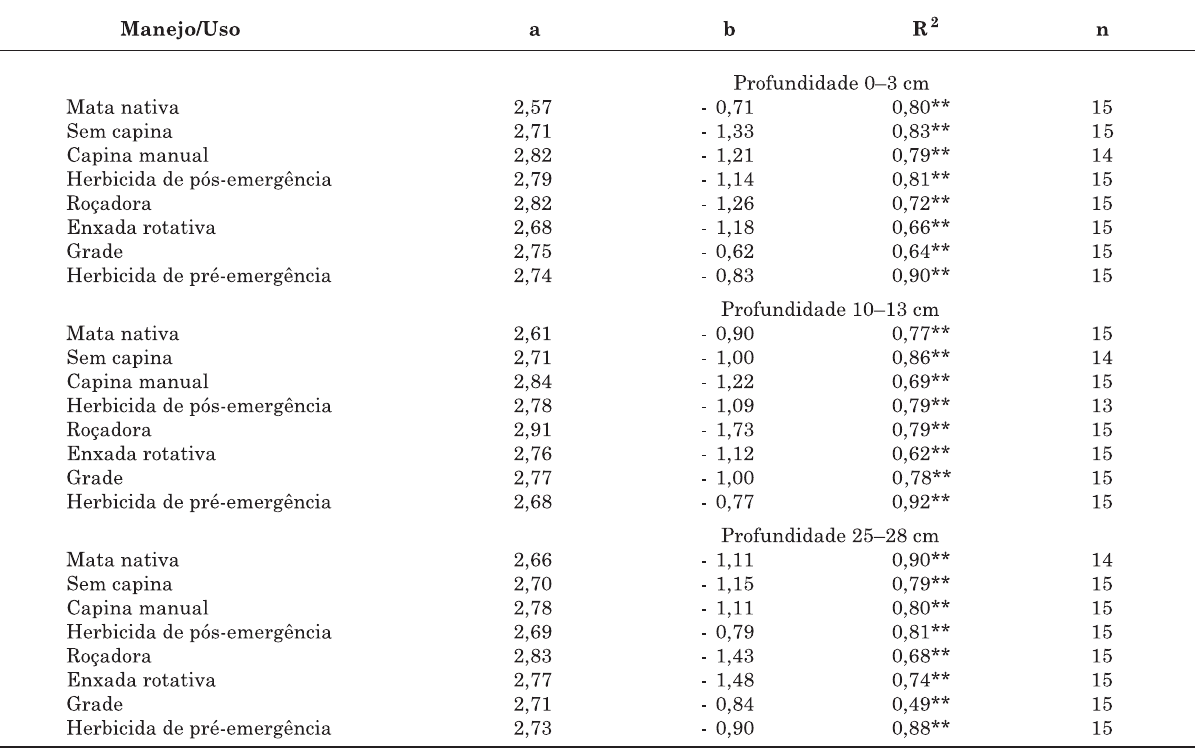
de manejo de plantas invasoras